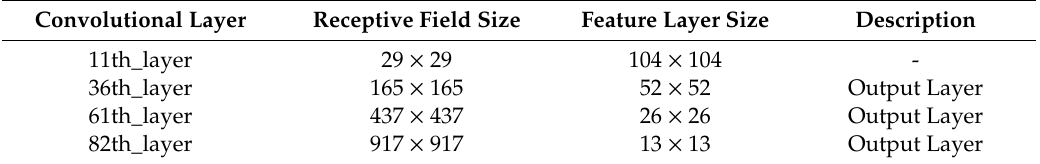
Table 3. The receptive field size of the last feature layer of relevant size in the original YOLOv3.